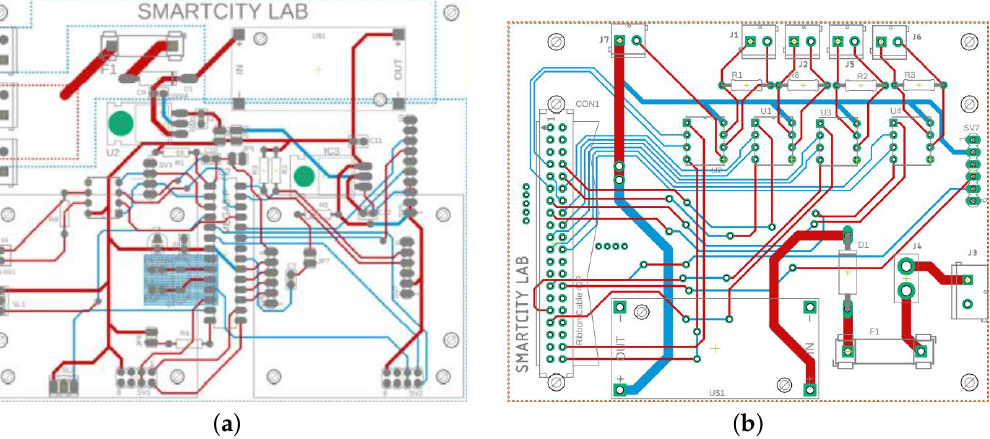
Figure 5. ( a ) Arduino Uno-based slave PCB layout and ( b ) Raspberry Pi-based Master PCB